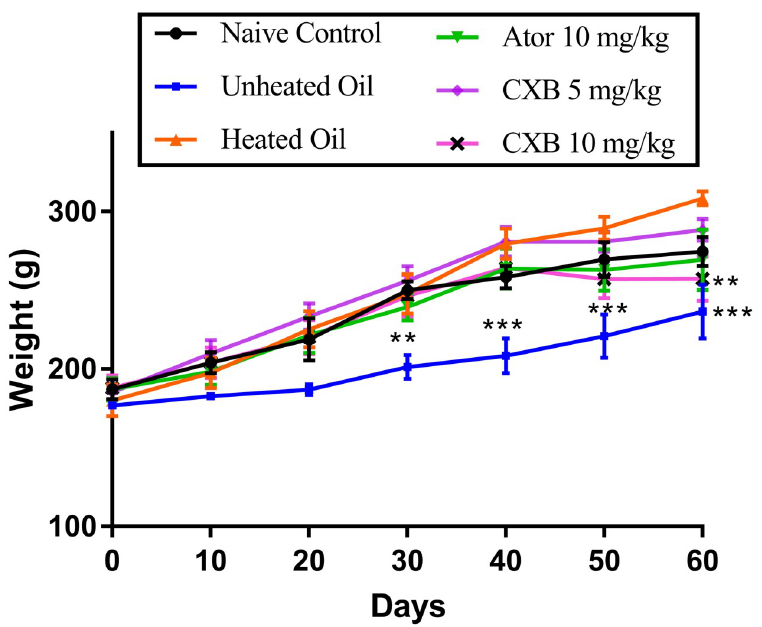
Fig 1. Effect of celecoxib (CXB 5 and 10 mg/kg) and atorvastatin (ATO 25 mg/kg) on the total body weight of rats. The symbol �� and ��� represent significant differences ( P < 0.01 or P < 0.001 respectively) between treatment groups and heated oil only group (all were compared using two-way ANOVA followed by Tukey’s post hoc test).